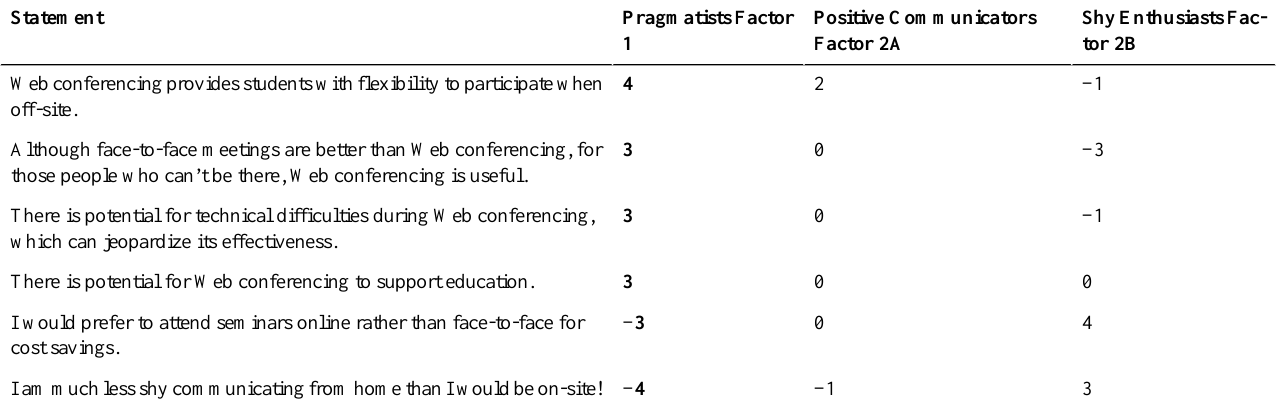
Table 2. Factor 1 scores for distinguishing statements for pragmatists (n = 26)*